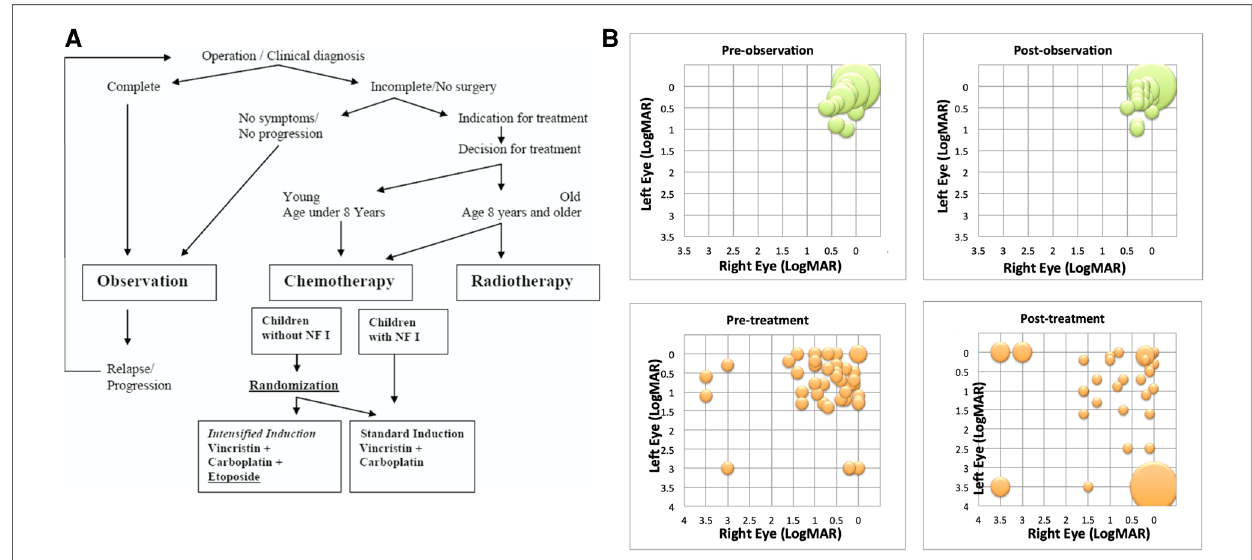
FIGURE 3 ( A ) Patient selection criteria for observation vs. treatment in SIOP LGG 2 (004 randomised trial (17). ( B ) Comparison of LogMAR visual acuity results from SIOP LGG 2004 workshop comparing pre- and post- bilateral visual acuity for observation (top green graphs) and treatment (lower orange graphs) with vincristine and carboplatin in patients with NF1